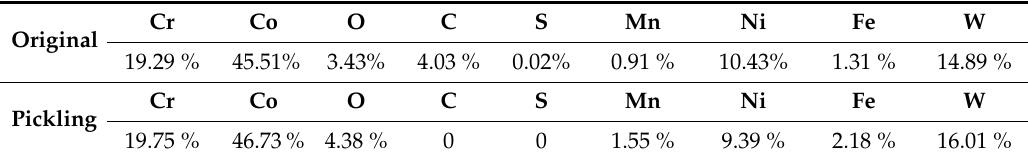
Table 5. Chemical composition on the argon cuts surface.